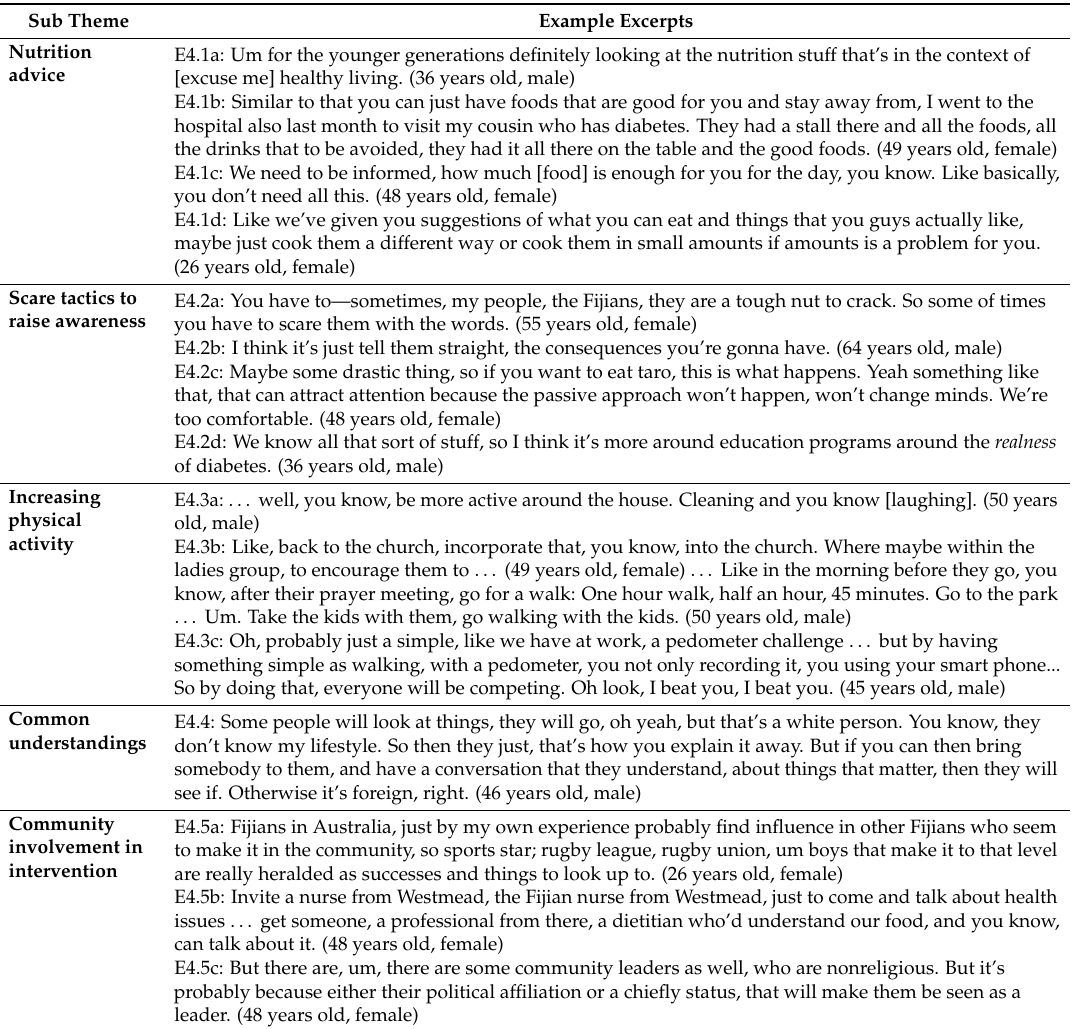
Table 5. Excerpts related to recommendations for components of an